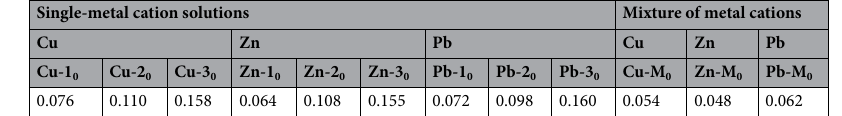
Single-metal cation